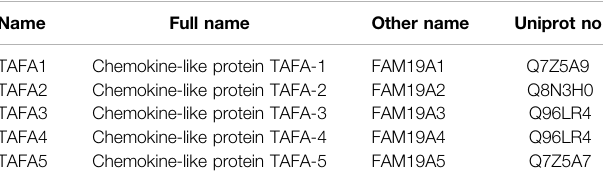
TABLE 1 | Nomenclature of human TAFAs and